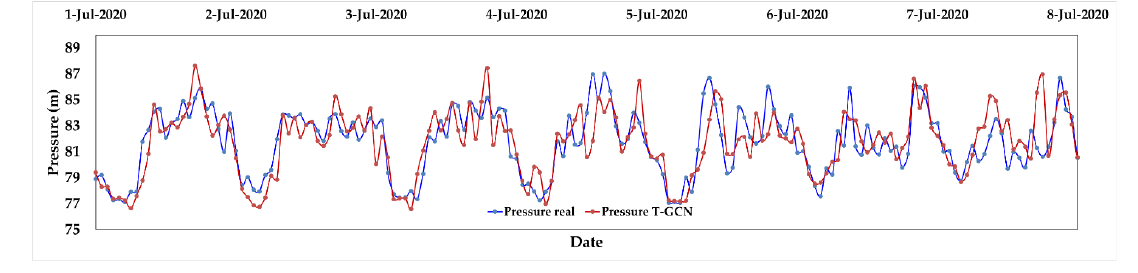
Figure 8. Comparison between estimated pressure based on real and estimated relative pump speed.